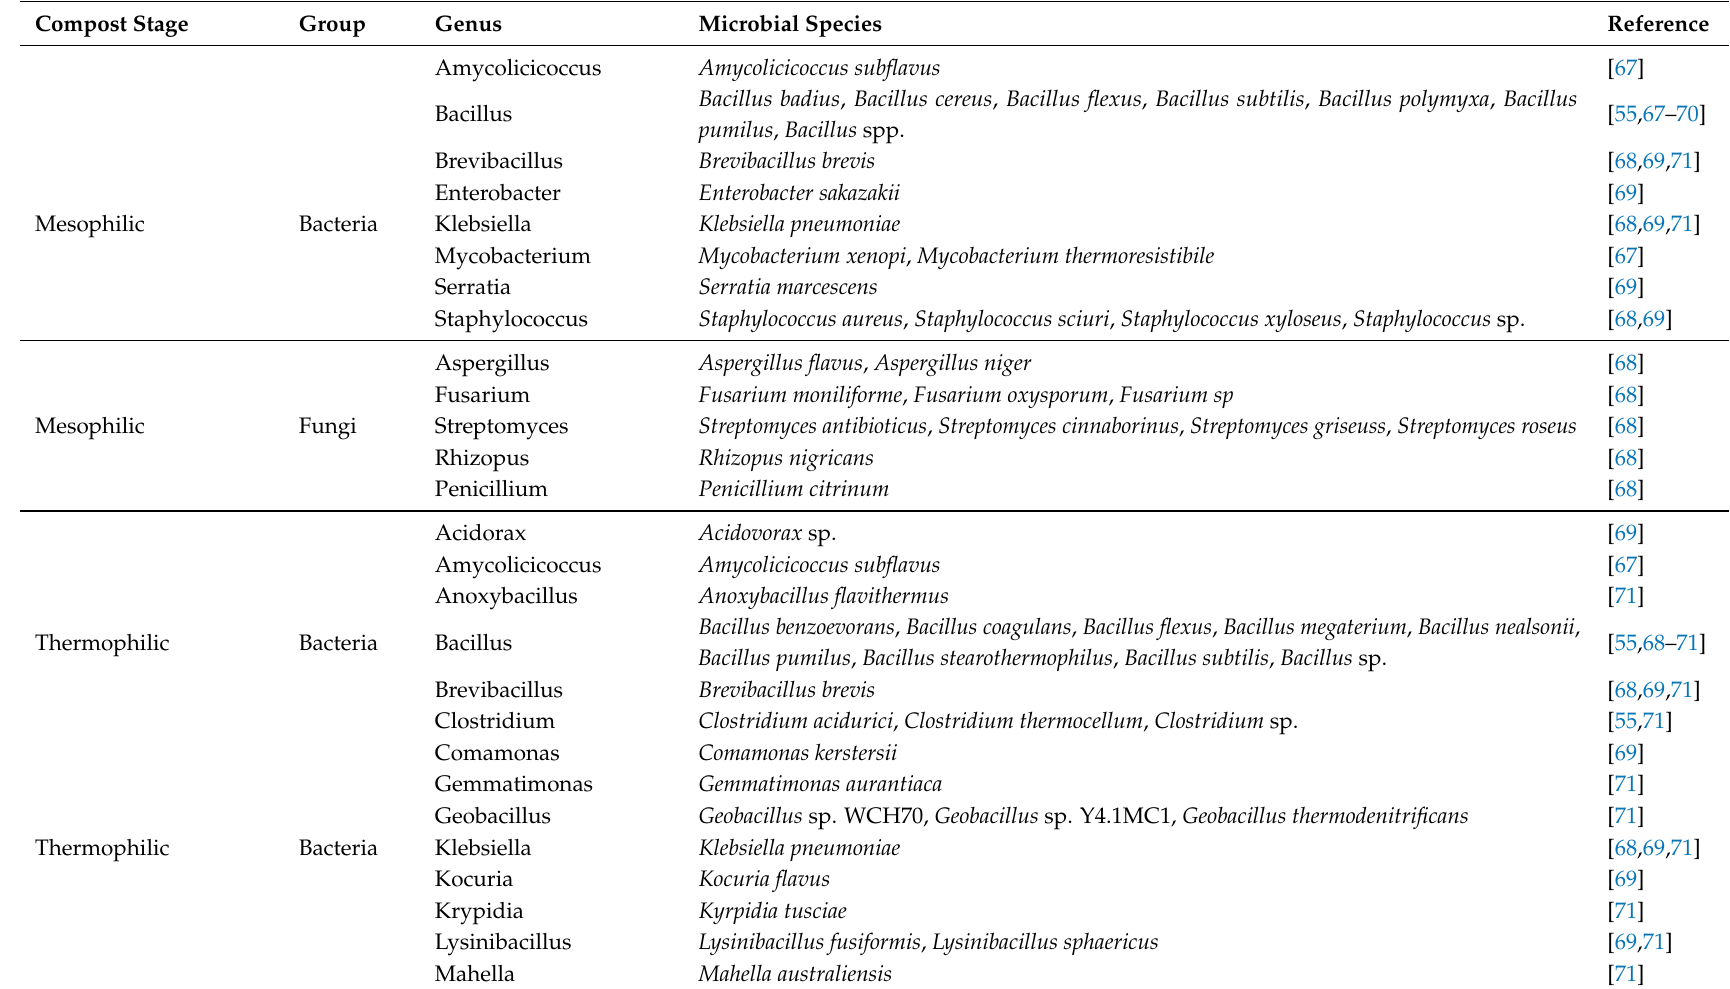
Table 5. Diversity of microbial populations according to respective composting